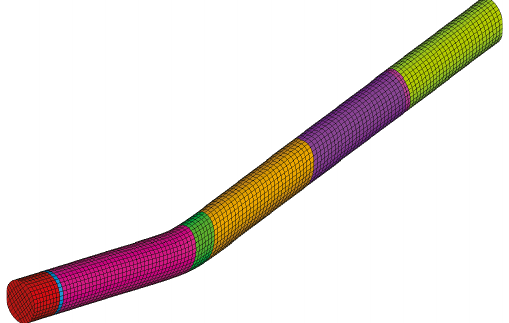
Figure 6: Water-conveyance